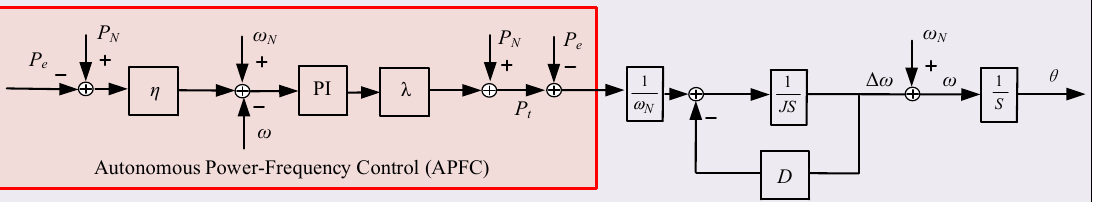
Figure 5. Autonomous power-frequency control (APFC).